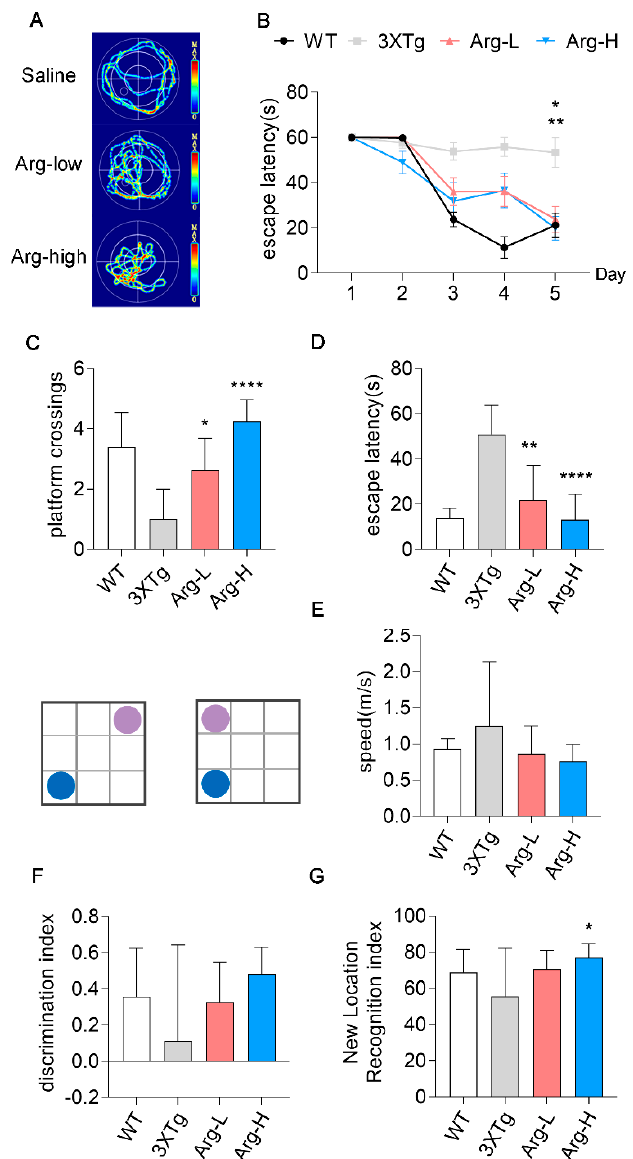
Figure 5. Arginine attenuates the impairments of hippocampal − dependent spatial learning in memory in 3 × Tg mice. In the MWM test, mice (WT, n = 5; Saline group, n = 5; Arg − low, n = 8; Arg − high, n = 8) underwent 5 consecutive days for learning ability tests. ( B ) The latencies to reach the hidden platform were recorded each day. In the probe trial, the latency time of first reaching the platform ( D ), numbers of platform crossings ( C ), swimming speed ( E ), and representative swimming routes ( A ) were recorded. ( F ) The discrimination indexes were recorded. ( G ) Arg − high treatment increased the novel location recognition index in 3 × Tg mice. Data were expressed as mean ± SD ( n = 3). ( B ) was analyzed by two − way repeated − measures ANOVA with a post hoc Bonferroni’s test. ( C , D ) were measured by one − way ANOVA with a post hoc Tukey’s test. * p < 0.05, ** p < 0.01, **** p < 0.0001 vs. 3 × Tg.